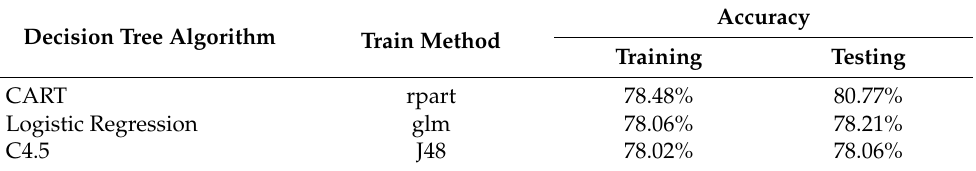
Table 11. DT Algorithms